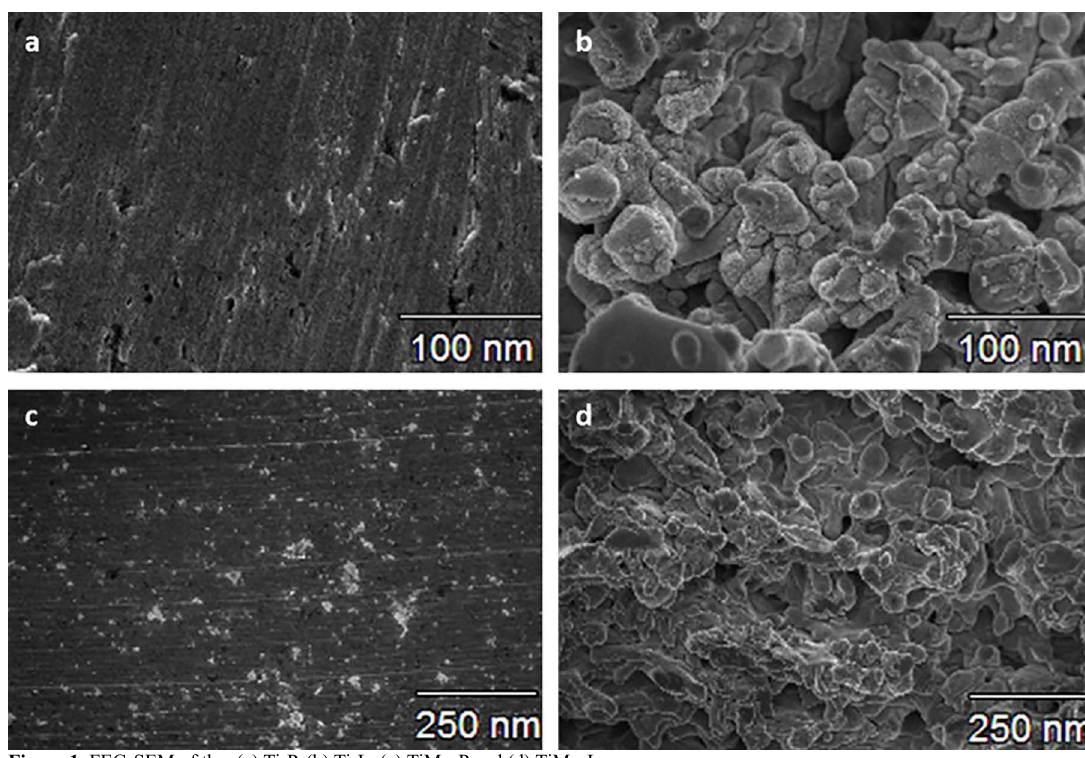
Figure 1. FEG-SEM of the: (a) Ti-P, (b) Ti-L, (c) TiMo-P and (d) TiMo-L.